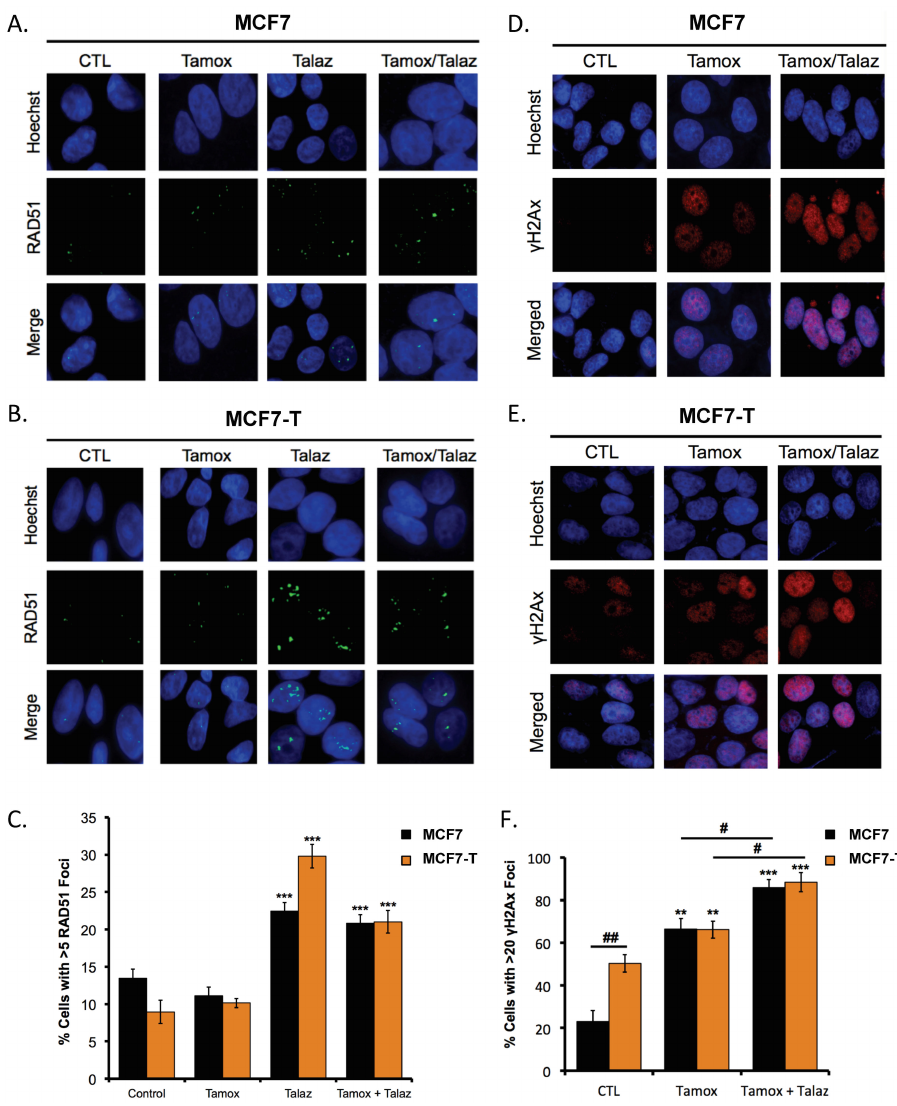
Figure 2. Tamoxifen-talazoparib co-administration induces DNA damage but not RAD51 foci formation. ( A ) MCF7 and ( B ) MCF7-T cells were treated with either 100 nM tamoxifen (Tamox) or 1 nM talazoparib (Talaz) for 72 h, alone and in combination. 24 h post treatment RAD51 foci formation assay was performed. Scale bar: 20 µ m. ( C ) Quantification is representative of three individual experiments. ( D ) MCF7 and ( E ) MCF7-T cells were treated with 100 nM Tamox, with and without 1 nM Talaz for 48 h. 24 h post treatment cells immunofluorescence staining for γ H2 AX was performed. Scale bar: 20 µ m. ( F ) Quantification is representative of three independent experiments. * p < 0.001, *** p < 0.0001 compared to control, # p < 0.01, ## p < 0.001 relative to bracketed treatment. Because no specific effect on RAD51 was observed, we next examined DNA damage more generally. MCF7 and MCF7-T cells were treated with tamoxifen in the presence and absence of talazoparib, and immunofluorescence staining for γ H2Ax foci formation was performed. In response to tamoxifen alone, we observed increased ( p < 0.05) γ H2Ax staining, which was further increased ( p < 0.05) by co-administration with talazoparib (Figure 2D–F). These findings are consistent with a previous study by Qi et al. showing that tamoxifen can impair homologous recombination repair, while promoting DNA damage accumulation